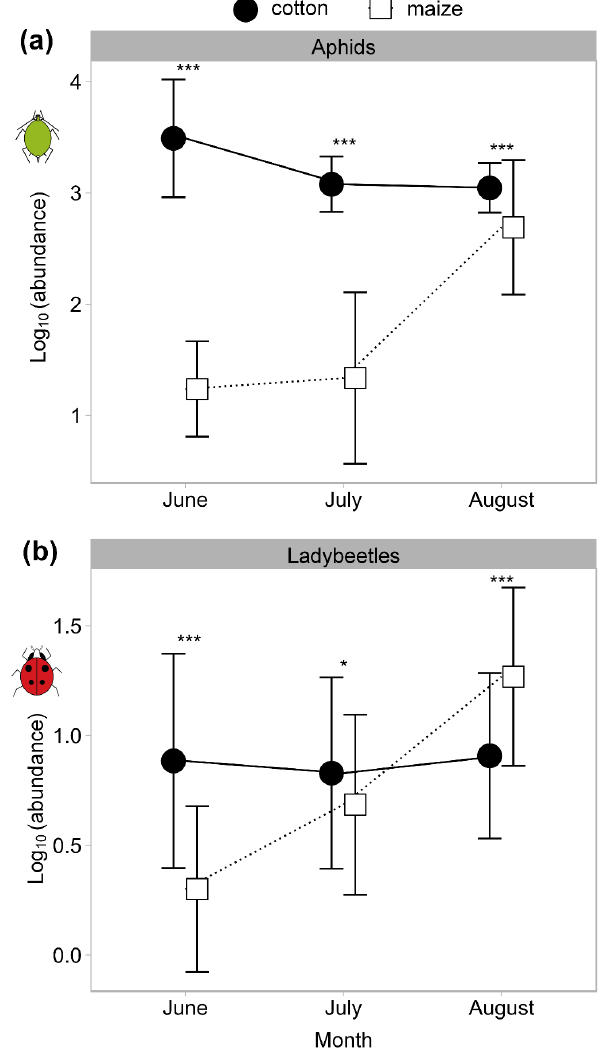
Figure 3. The population density of aphids and ladybeetles in different sampling periods (months) on cotton and maize crops at the regional landscape scale in 2013. ( a ): aphid density (AD); ( b ): ladybeetle metapopulation density (LMD). The data are the average ± S.E. with log 10 (x + 1) transformed before using repeated-measures analysis with a mixed effect linear model (“proc mixed” in the SAS software). Asterisk (*) indicates the significant difference between cotton and maize in different sampling months, * p < 0.05, *** p < 0.001.